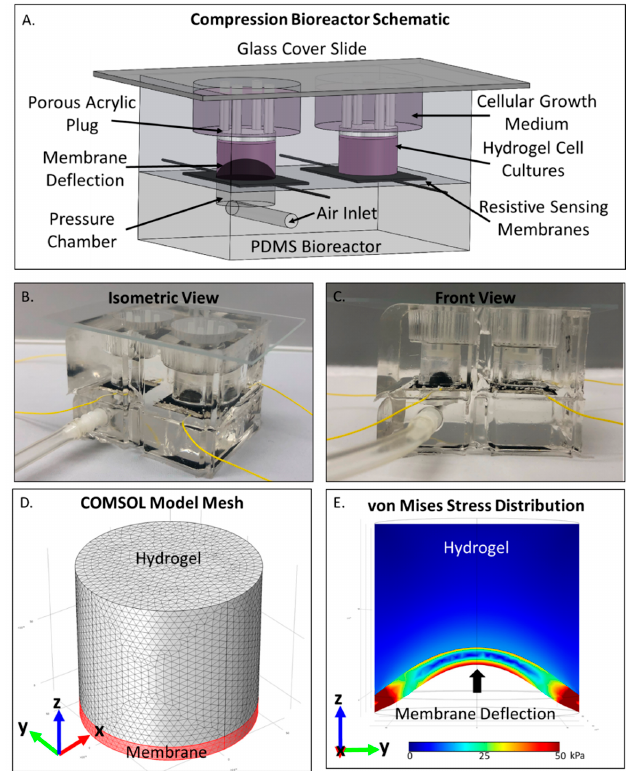
Figure 1. Ovarian cancer compression bioreactor schematic and computational model. ( A ) SolidWorks rendering of the compression bioreactor. Air is pumped into the underlying pressure chamber which deflects into the cancer cell laden interpenetrating hydrogel. The 3D cellular hydrogel component is held in place via a porous acrylic plug which also allows cell culture medium access from the top of this chamber; ( B ) Isometric view of a representative compression bioreactor; ( C ) Front view of a representative compression bioreactor with air pressure applied to demonstrate deflection of resistivity sensing membrane (black dome); ( D ) Mesh construction on COMSOL model of the hydrogel (1 cm height by 6 mm radius) and deflectable membrane (1 mm height by 6mm radius); ( E ) Sample output of COMSOL analysis showing center slice through z-y plane. Deformation of the membrane and hydrogel are shown with an applied pressure of 20 kPa. Average compressive stress within the hydrogel is 5.2 kPa.